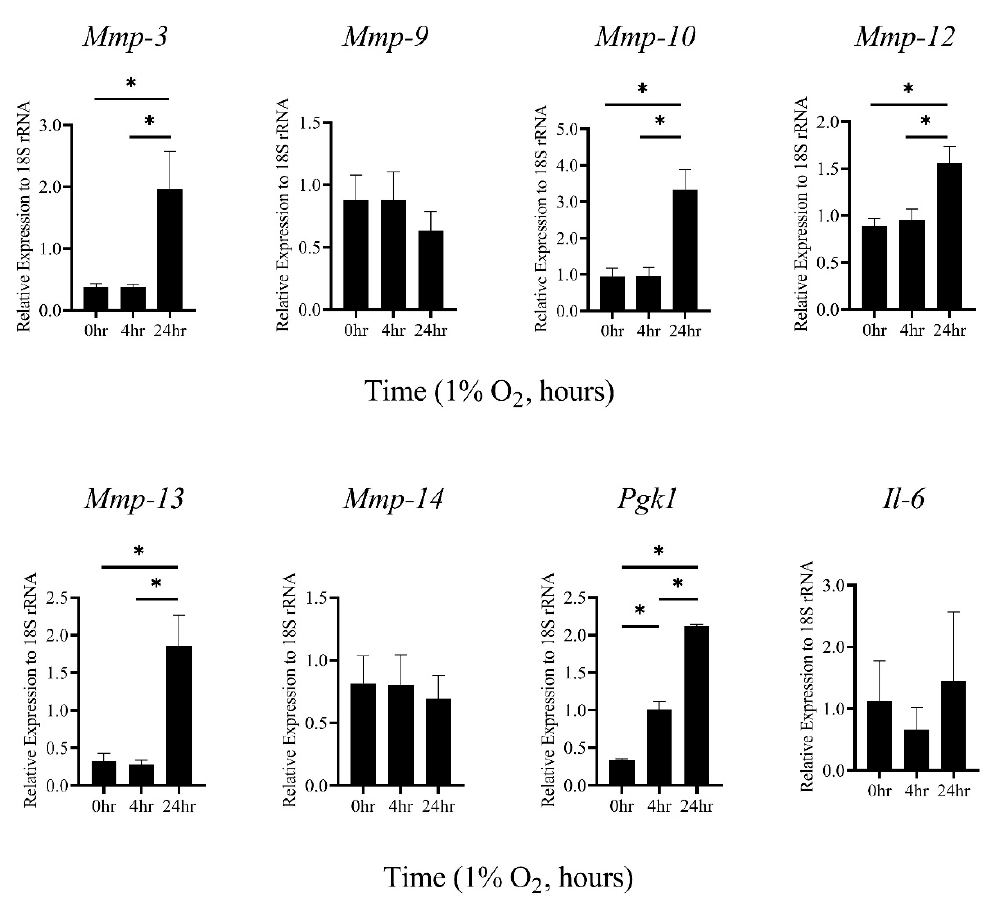
Figure 1. MMP -3, -10, and -13 mRNAs in TEPMs are induced by hypoxia. TEPMs were exposed to hypoxia (1% O 2 ), and the relative expression level of MMPs mRNAs was analyzed. Data are the means and SE of at least three independent experiments. The one-way ANOVA and Tukey’s multiple comparisons test were performed for the statistical analysis. * p < 0.05.